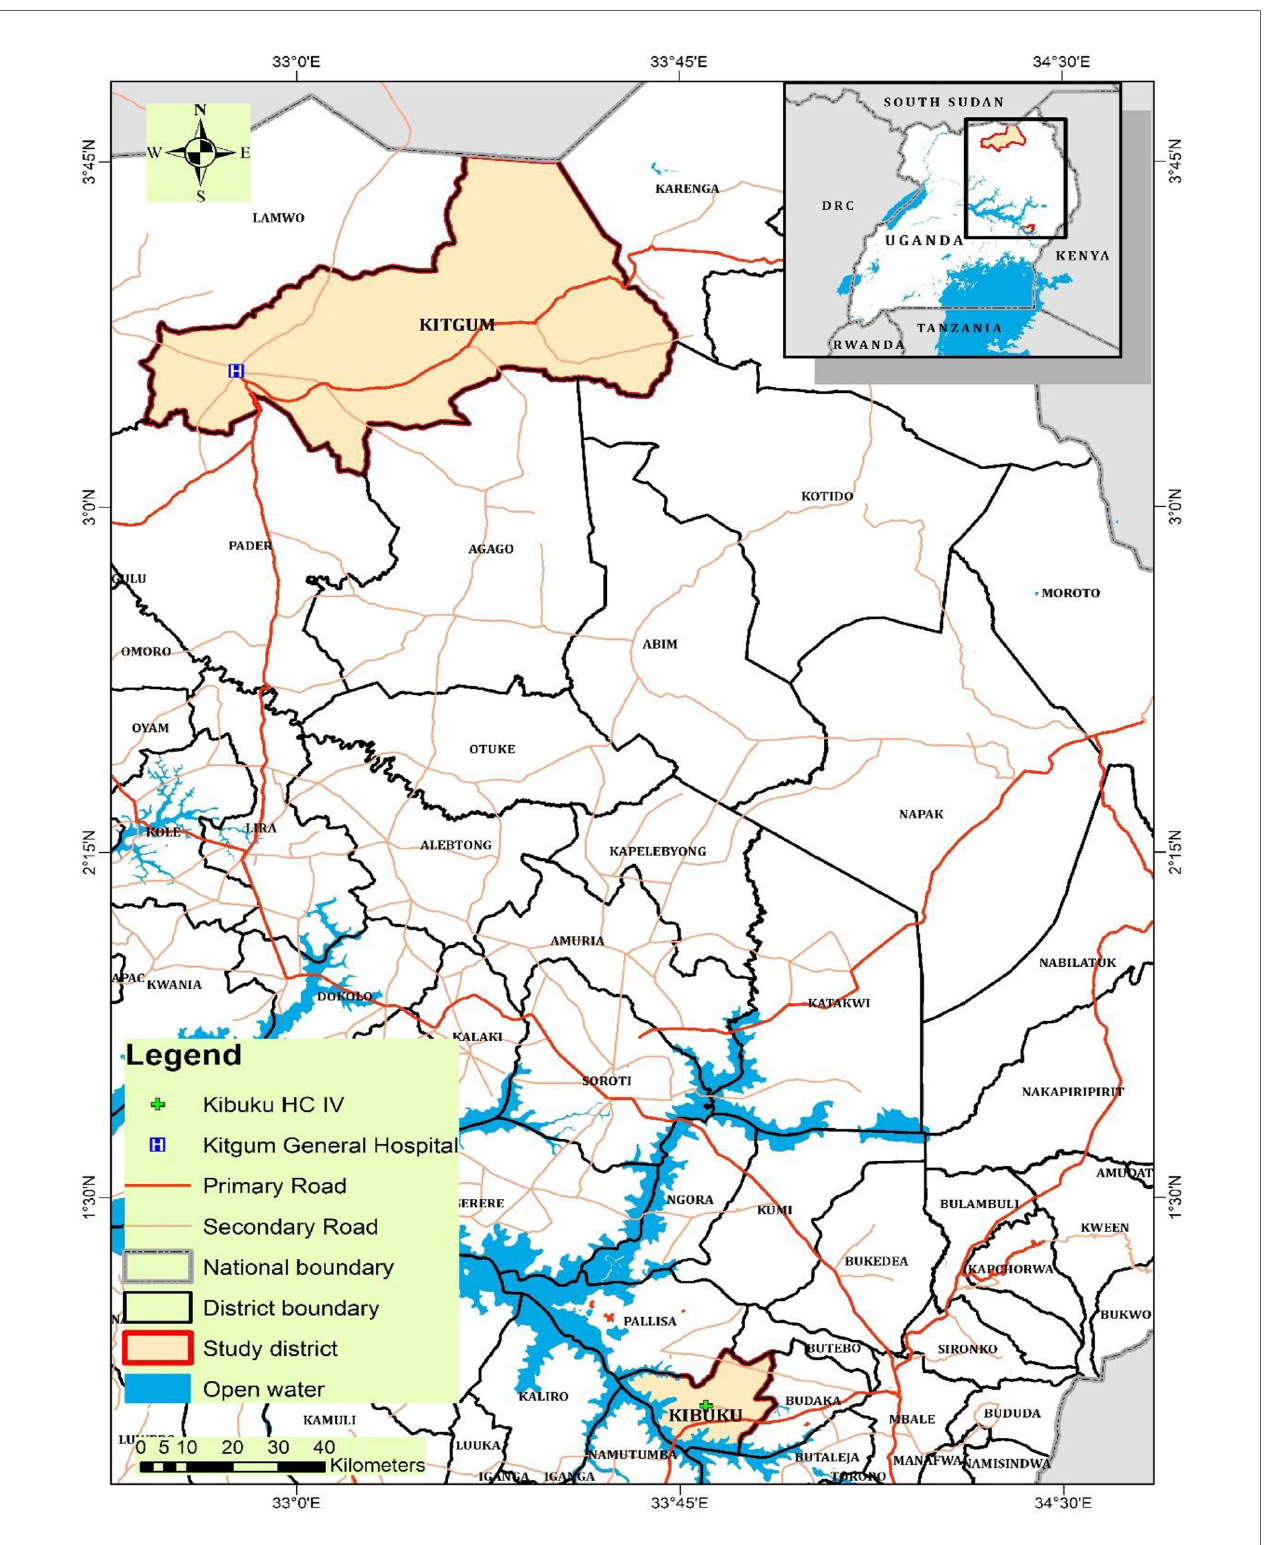
FIGURE 2 | Study sites from both low and high endemic